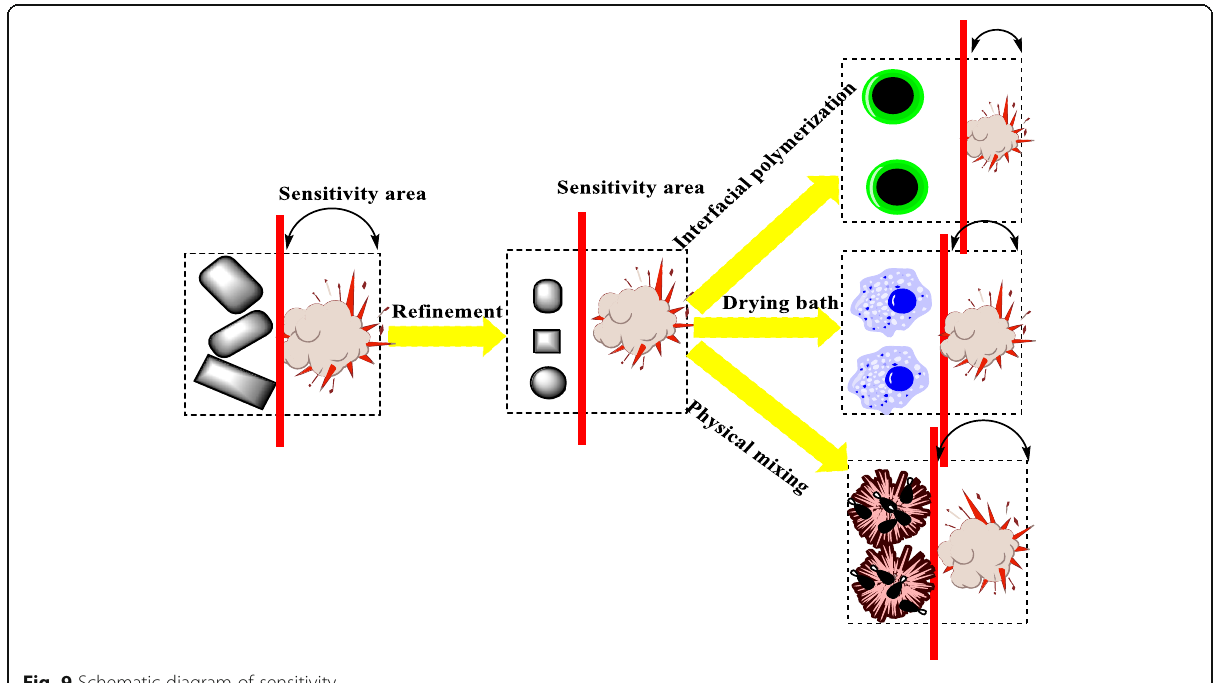
Fig. 9 Schematic diagram of